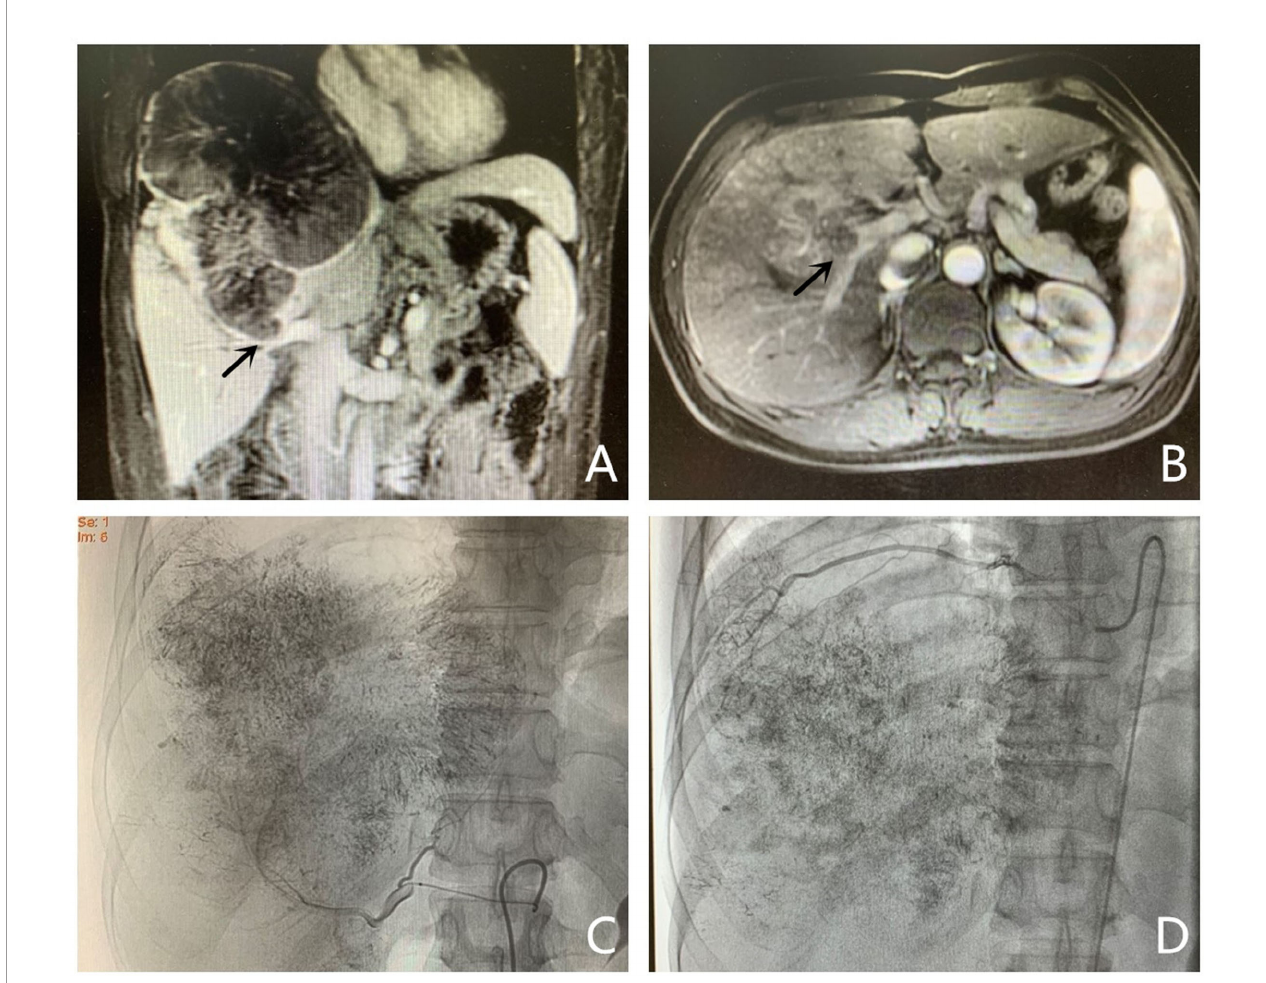
FIGURE 1 | Photographs acquired by magnetic resonance imaging (MRI) and transarterial chemoembolization implemented in a 44-year-old man (PVE + TACE group). (A, B) Hepatocellular carcinoma with ipsilateral PVTT, with an intraluminal fi lling defect which was a low-attenuation and spread from the intrahepatic portal vein branches (black arrow), was detected in the right lobe on enhanced abdominal MRI before therapy. (C, D) Images of transarterial chemoembolization. Tumor- feeding arteries are con fi rmed using digital subtraction angiography. Lipiodol, chemotherapeutic agents, and microspheres were injected into the right hepatic (C) and right phrenic arteries (D)